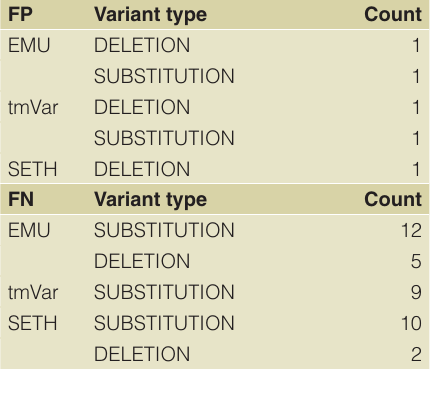
Table 7. Protein variant extraction error types and their frequency are presented for each system. The tools are Extractor of Mutations (EMU),